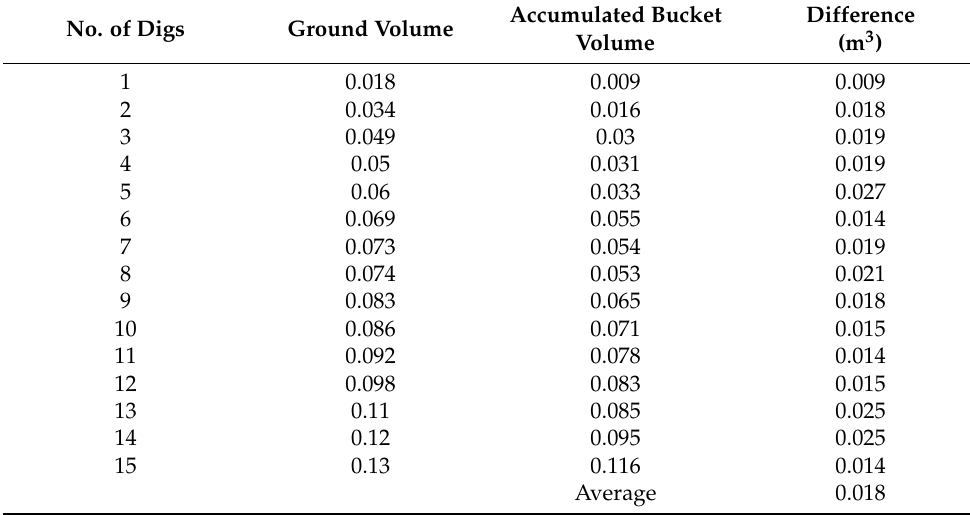
Table 2. Comparison of ground volume and accumulated bucket volume estimation.